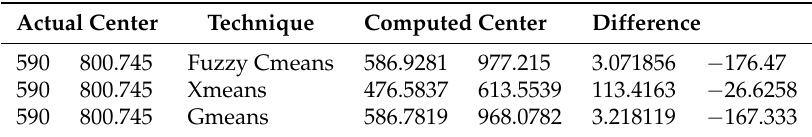
Table 4. Comparison of Clustering